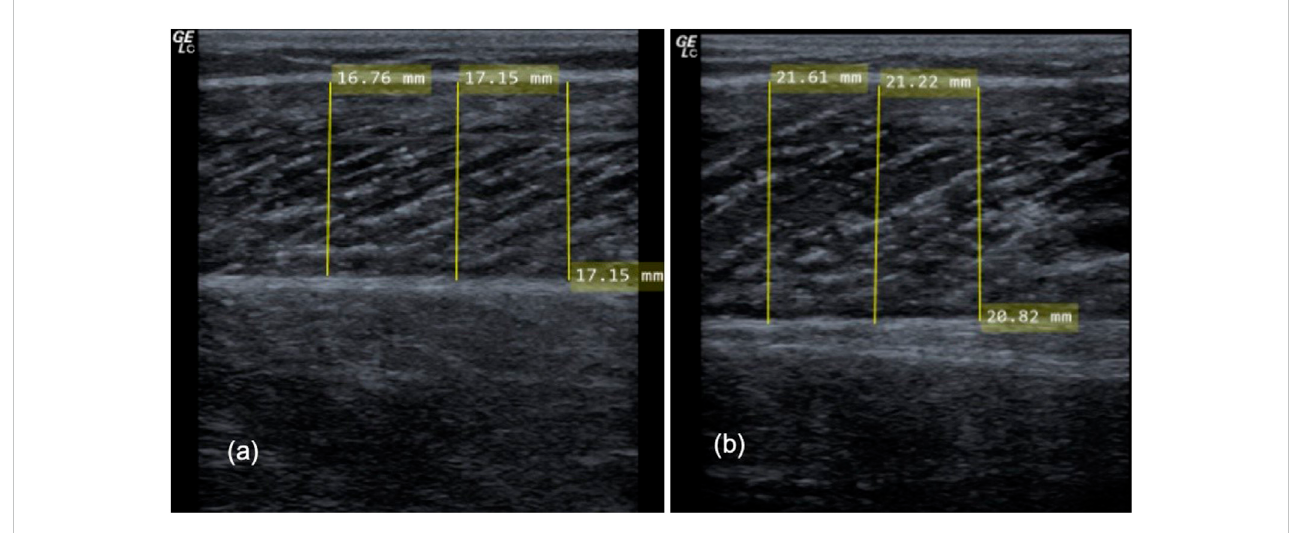
FIGURE 8 Illustrating the progression in muscle thickness (MTh) in the pre-test (A) and the post-test (B)